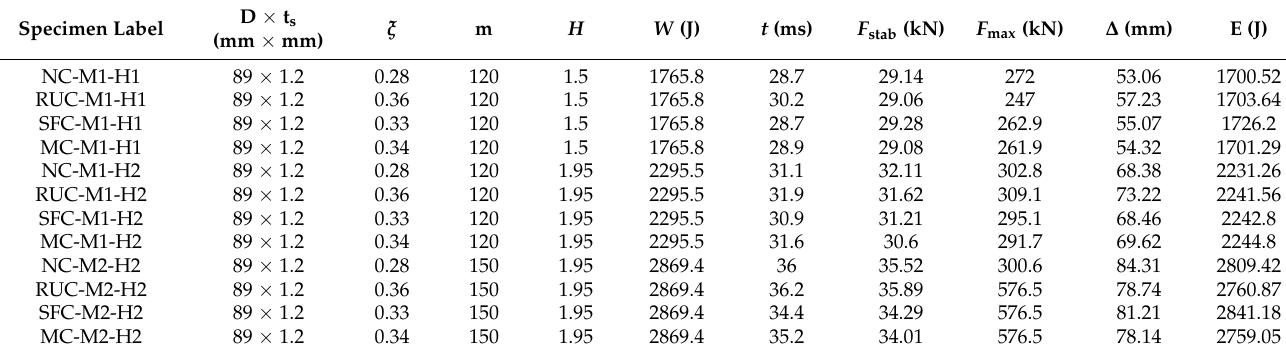
Figure 13. Time history of the impact force of the drop hammer. Table 2. Results of experimental tests.